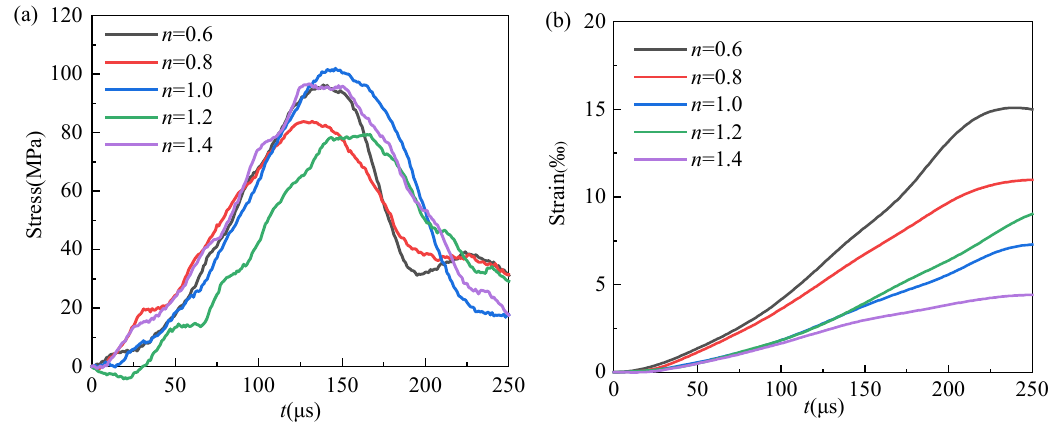
Figure 12. Stress ( a ) and strain ( b ) time history curve.